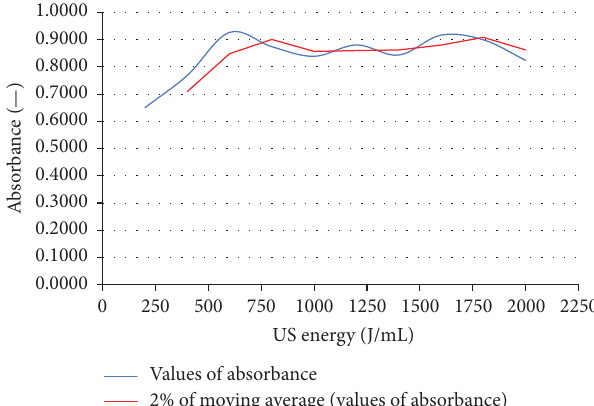
Figure 1: Results of absorbance measurement. The optimal value of US energy was determined by finding the curve’s inflection point— 800 J/mL. At this point, the absorbance (CNT’s dispersion) is at its peak value and further ultrasonication is unnecessary.